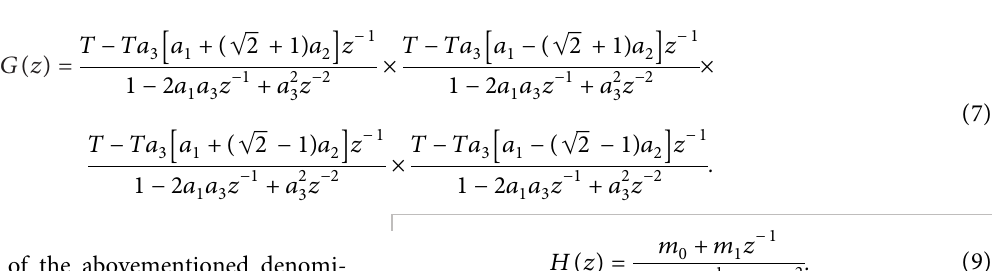
Figure 2: Mathematical model of basement